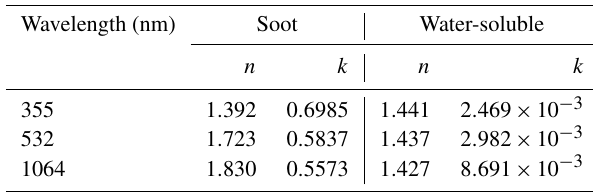
Table 1. Complex refractive index ( n + i k ) of soot and water-soluble (WS) components used for light-scattering calculations (Figs. 6– 10). A relative humidity of 50% was assumed for the WS compo-